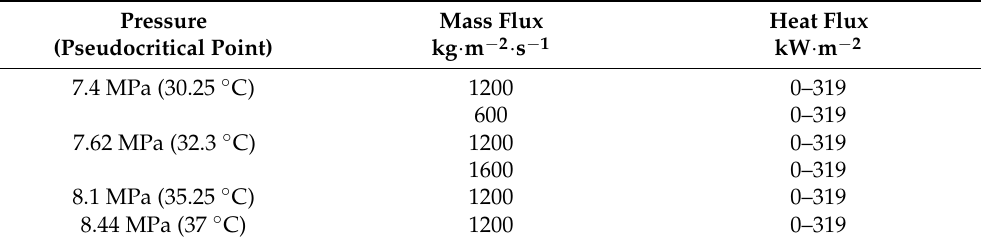
Figure 2. Test section and distribution of measurement points. Table 1. Measurement conditions under different pressure and mass flux